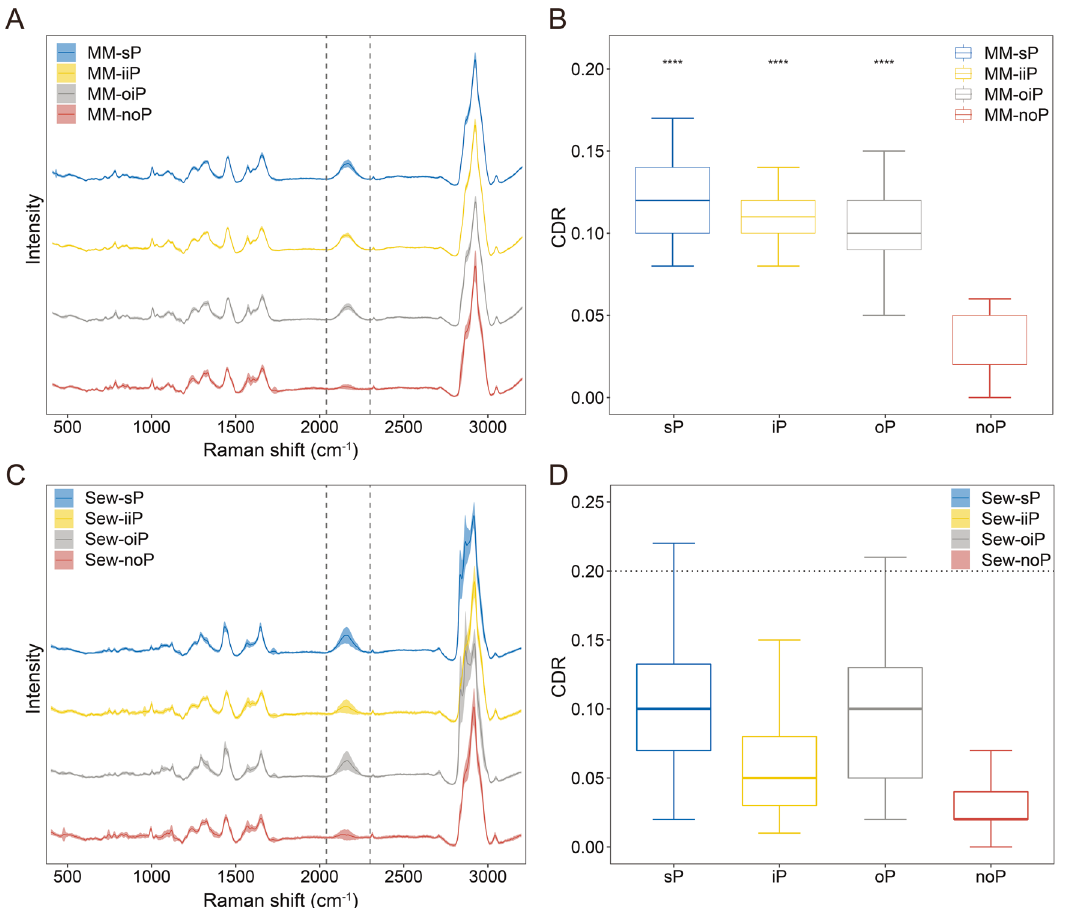
Fig. 3 The P-solubilizing activity of indigenous sewage bacteria as quanti fi ed by Single-Cell Raman Spectra. SCRS ( A ) and the corresponding C-D ratio ( B ) of sewage bacteria incubated in the arti fi cial culture media of MM-sP, MM-iiP, MM-oiP or MM-P_free with 50% D 2 O for 24 h, respectively. For comparison, also shown are SCRS ( C ) and the corresponding C-D ratio ( D ) of sewage bacteria incubated in dephosphorization sewage with 50%-D 2 O, either with no P (Sew-noP; as negative control) or supplemented with soluble P (Sew-sP),